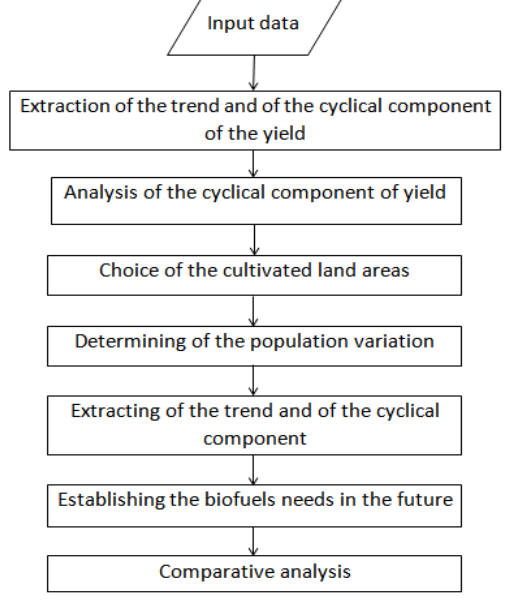
Figure 3. Methodology flow-chart.